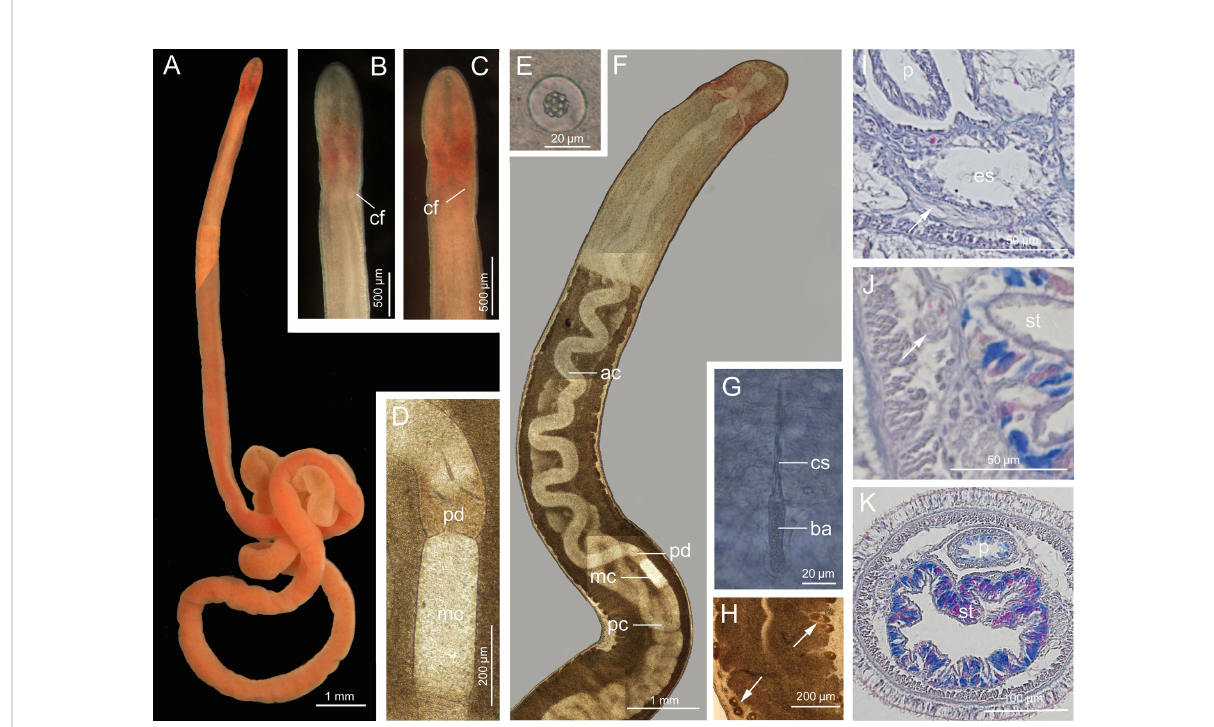
FIGURE 6 Ototyphlonemertes ( Norenburgia ) sinica sp. nov. (A) Photograph of a live specimen; (B) dorsal view of head; (C) ventral view of head; (D) photomicrograph of partial proboscis from squeezed specimen; (E) statolith; (F) composite photomicrograph of a squeezed specimen; (G) central stylet and basis; (H) intestinal region a squeezed specimen, showing ovaries (arrowed); (I) transverse section through foregut region, showing extra ventral commissure (arrowed); (J, K) transverse section through stomach region, nephridia indicated by arrow. ac, anterior chamber of proboscis; ba, basis; cf, cephalic furrow; cs, central stylet; mc, middle chamber of proboscis; es, esophagus; p, proboscis; pc, posterior chamber of proboscis; pd, proboscis diaphragm; st,